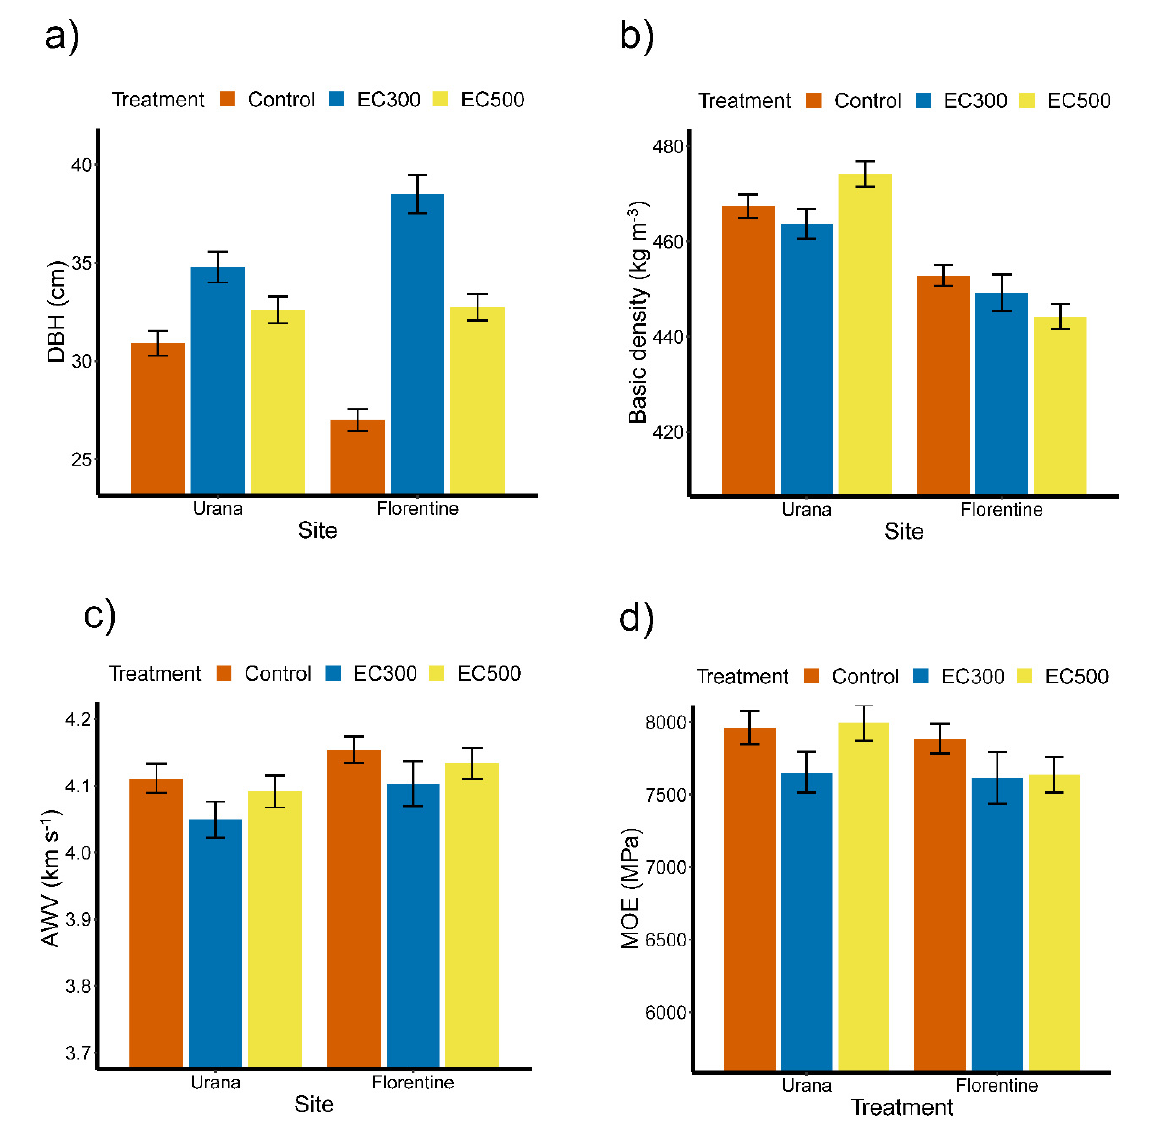
Figure 4. Least-square means and their standard errors estimated from the fitted third model showing the effect of commercial thinning (EC300, blue bar) and (EC500, yellow bar) relative to the untinned control (orange bar) on tree size (( a )—DBH) and wood properties (( b )—Basic density; ( c )—Acoustic Wave Velocity; ( d )—Modulus of Elasticity) at Urana and Florentine.